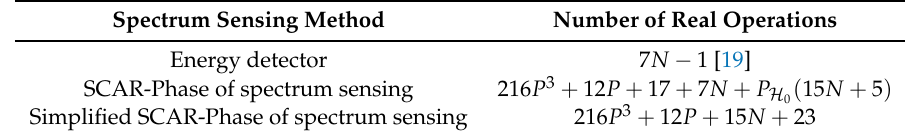
Table 1. Computational complexity comparison of the SCAR-Phase of spectrum sensing, the simplified SCAR-Phase of spectrum sensing and the energy detector in terms of the number of real operations.